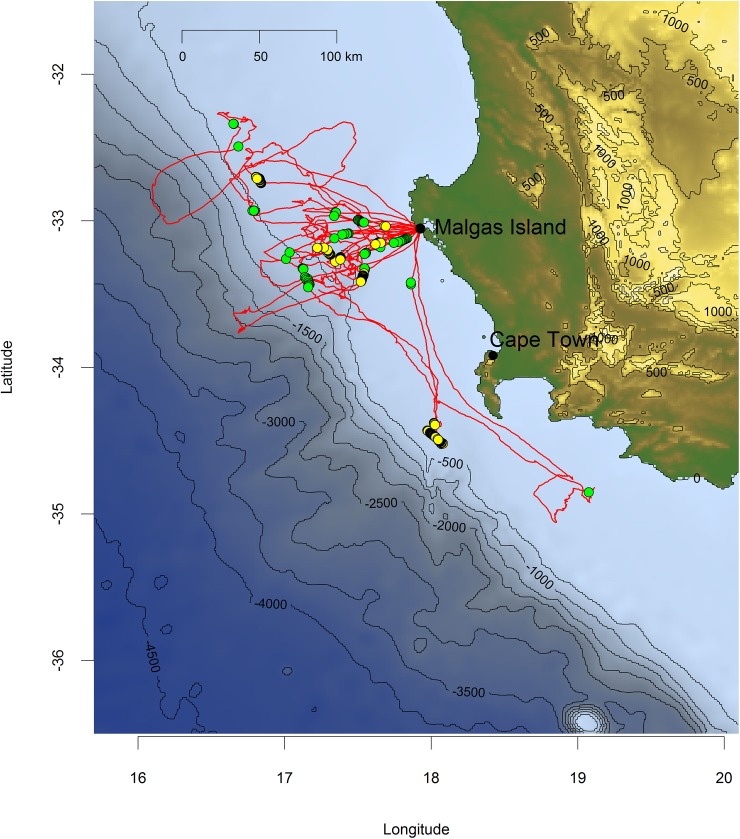
Foraging tracks of 13 Cape gannets during which vessel radar was detected.The seven detections with true bird-vessel attendance are indicated with yellow dots, whereas another 21 detections (green dots) featured short (<10 min) bird-vessel overlaps. Blue shades indicate bathymetry (R package marmap).